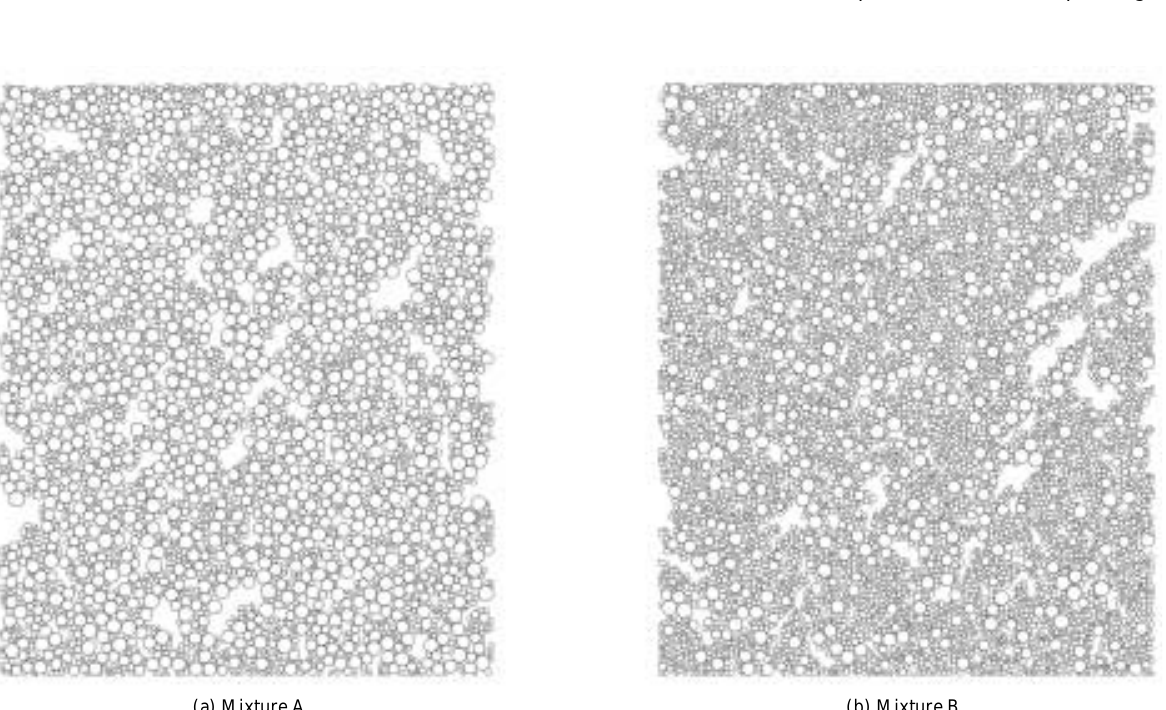
B.(a) Mixture A (b) Mixture Fig. 2 The initial open structure of polydispersed granular material of (a) mixture A; (b) mixture